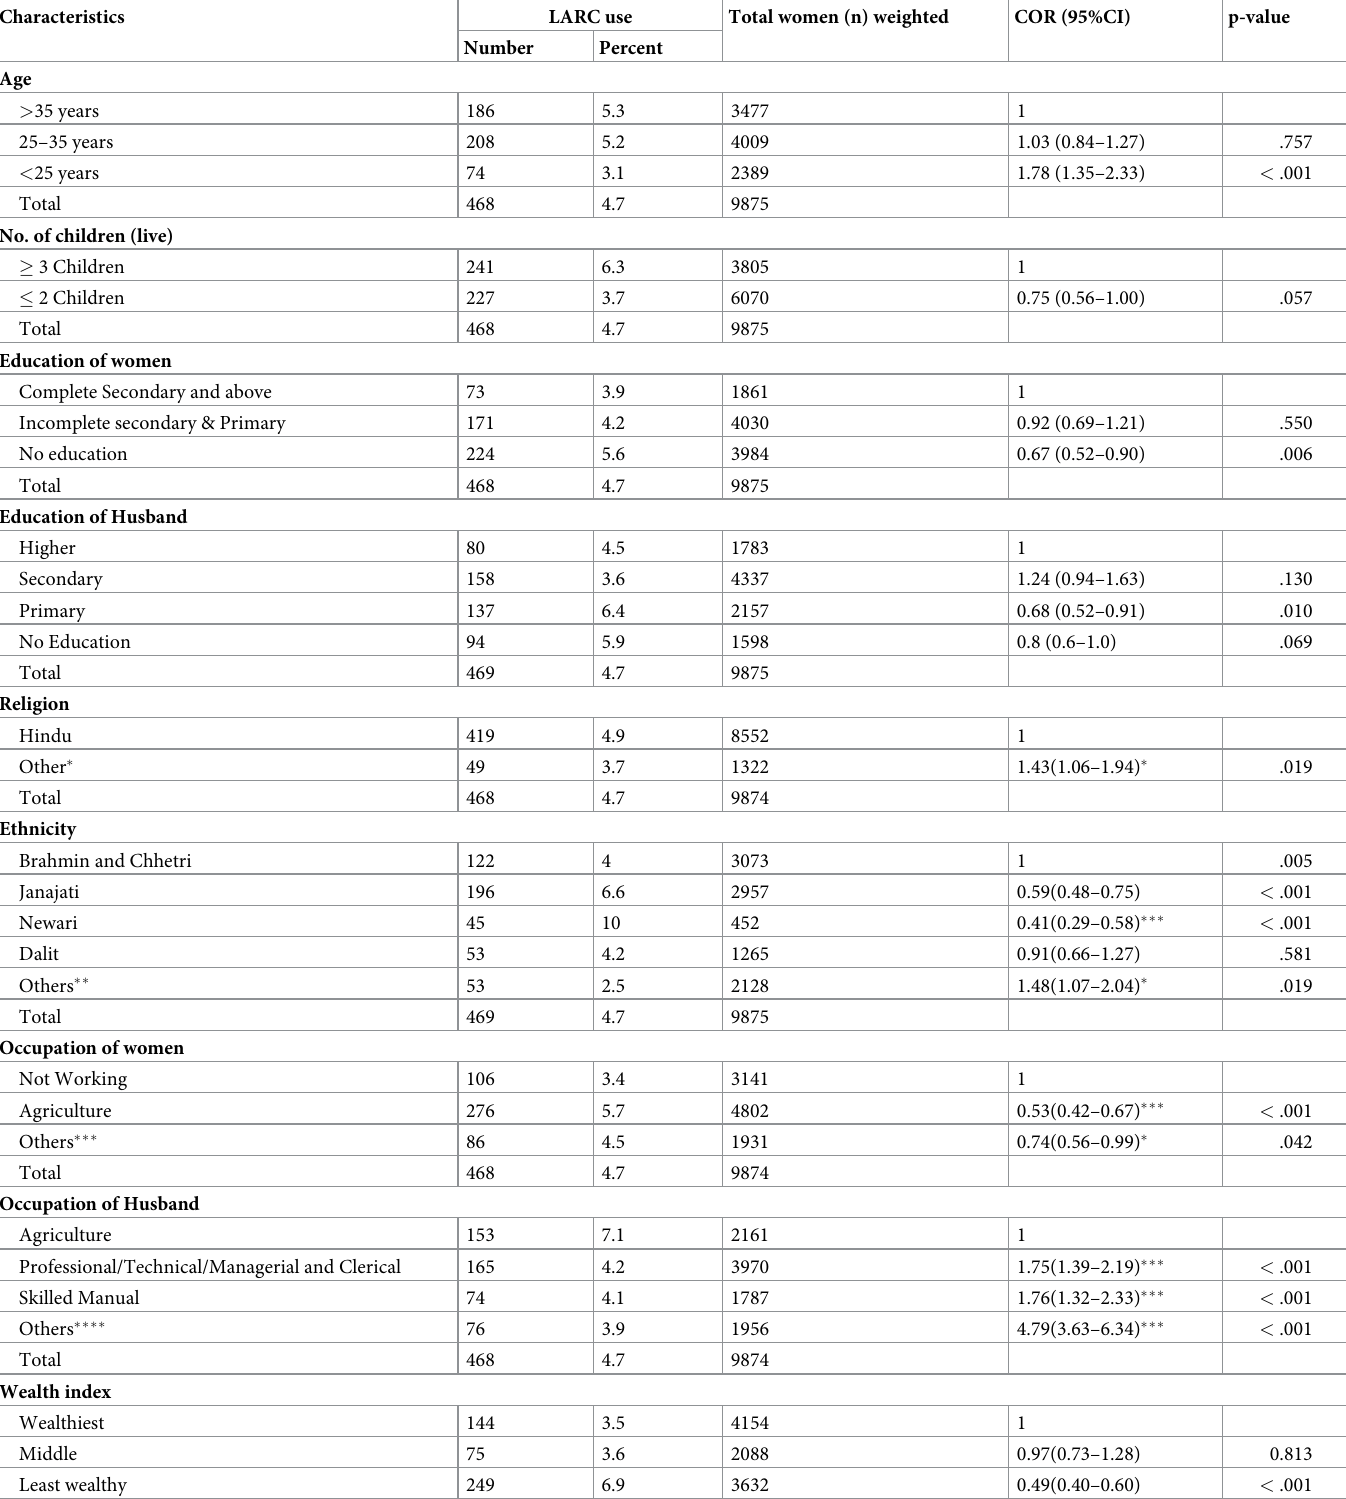
Table 1. Socio-demographic and economic characteristics and use of LARC.